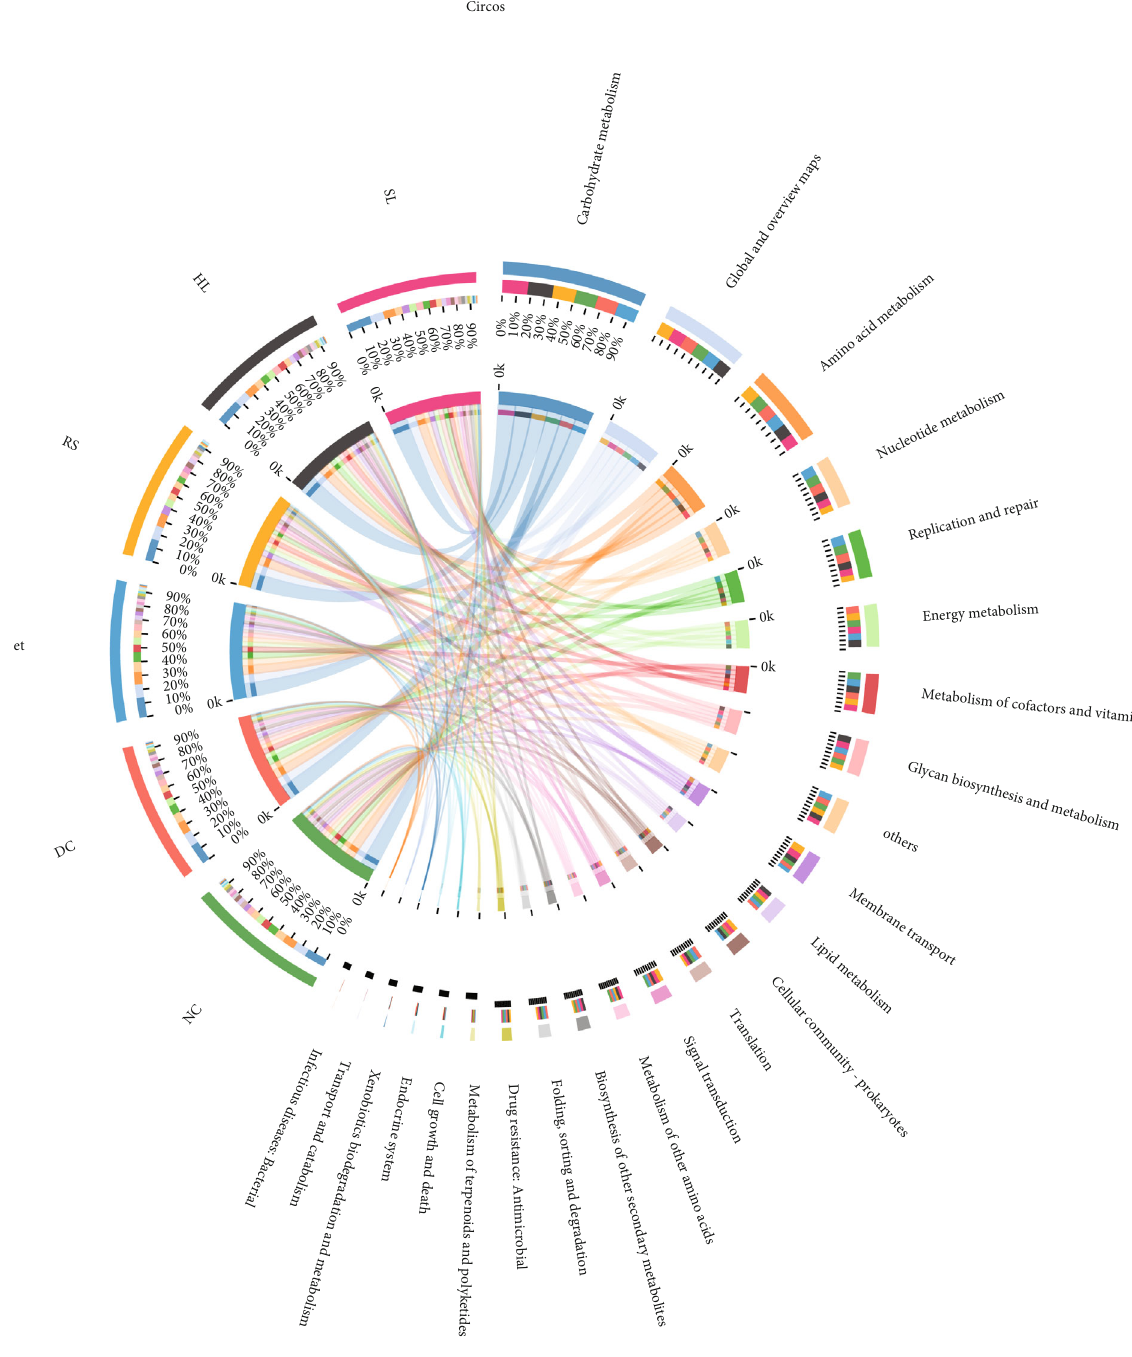
Figure 5: Circos diagram of the KEGG pathways enrichment analysis, the left half circle represents the function abundance composition of the group, and the right half circle represents the distribution ratio of the